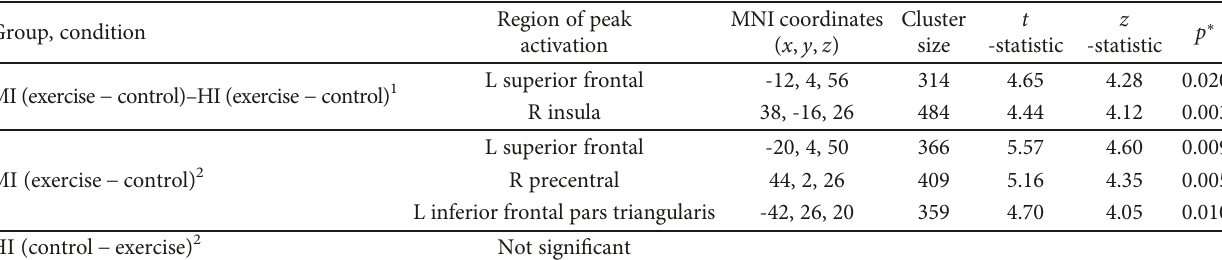
(Figure 3(a)): the fi rst cluster had a peak activation in the lin- gual gyrus and comprised the calcarine sulcus and cuneus; the second cluster was located in the precuneus and extended to the cuneus, the superior occipital gyrus, and the cerebel- lum; the third cluster extended from the anterior cingulate cortex to the midcingulate cortex. BOLD responses within those clusters showed decreased activation in the moderate- intensity group and increased activation in the high- intensity group in the exercise condition compared to the control condition (Figure 3(b)). Peak coordinates and statis- tical results are described in Table 4.